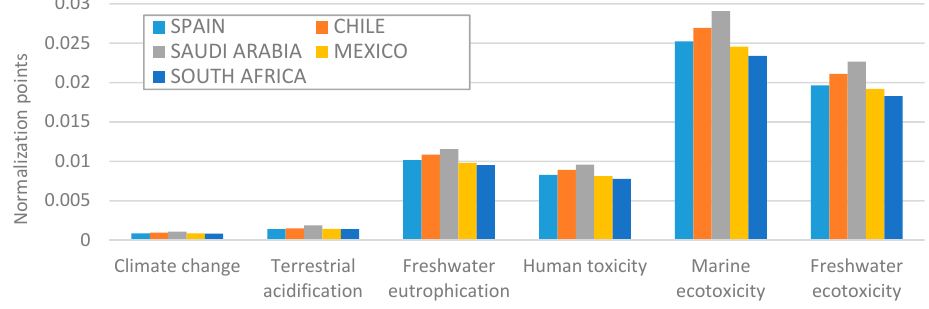
Figure 6. Normalization profile of the E&M phase of the HYSOL plant in different locations.